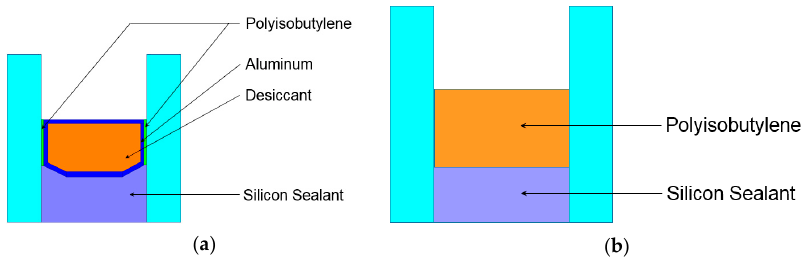
Figure 1. Spacer bar assemblies of a conventional aluminum spacer and a thermoplastic spacer (TPS): ( a ) aluminum spacer; and ( b ) thermoplastic spacer (TPS).